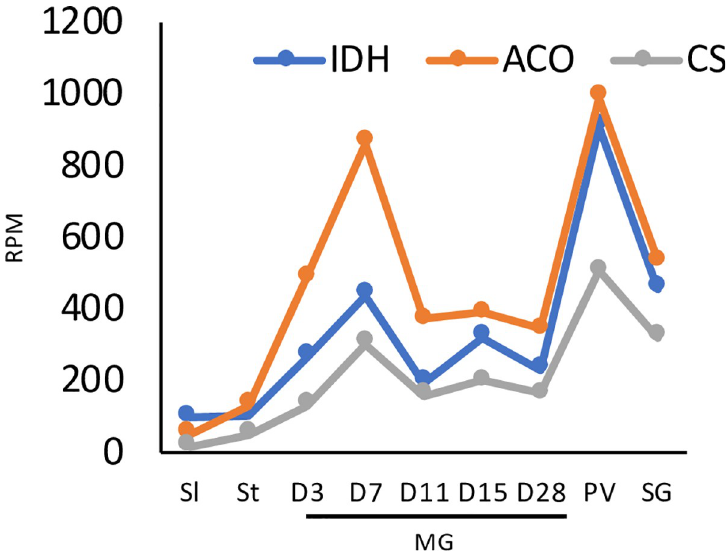
Fig 4. Expression profiles of TCA cycle enzymes through the life cycle. ACO, aconitase; IDH, isocitrate dehydrogenase; CS, citrate synthase. All three enzymes show bimodal expression, with highest expression at D7 in the midgut and in the proventriculus. Data for slender and stumpy forms are from [10]. RPM: reads per